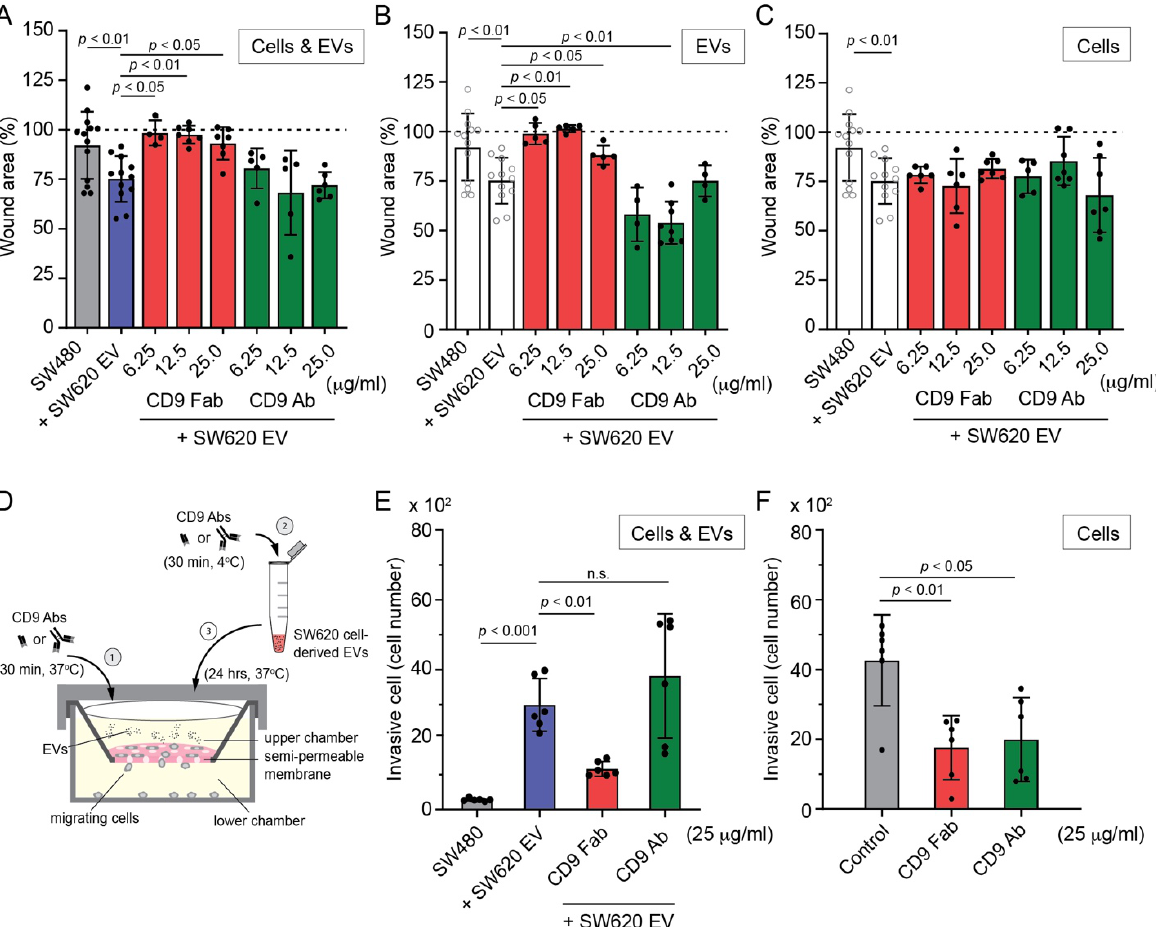
Figure 5. Effects of CD9 Fab and divalent Ab on the migration of SW480 cells exposed to SW620 cell-derived EVs. ( A ) The migration–wound healing assay was performed by introducing a scratch on confluent SW480 cell monolayers cultured on 12-well standard cell culture plates and incubating them for 5 h in the absence (negative control, grey) or presence (positive control, blue) of SW620 cell-derived EVs (1 × 10 9 particles/mL). Alternatively, after introducing a scratch on the cell monolayer, cells and EVs were individually pre-incubated for 30 min with different concentrations of anti-CD9 Fab (red) or divalent Ab (green) as indicated before their 5 h co-incubation in the presence of Abs ( A ). The percentage of remaining wound areas after 5 h was quantified. Baseline (100%, dashed line) refers to wound area at 0 h. ( B , C ) Solely EVs ( B ) or cells ( C ) were pre-incubated for 30 min with Abs prior to co-incubation with cells or EVs for 5 h. Wound area was quantified. Controls (white) are shown for comparison. Means ± S.D. from multiple scratches are shown ( n = 4–13). ( D – F ) The migration–Transwell filter assay was performed using a Transwell chamber as illustrated ( D ), where SW480 ( E ) or SW620 ( F ) cells were added to the upper chamber. Cells and EVs were pre-treated, as described in panel A, using 25 μg/mL CD9 Fab or divalent Ab (( D ), steps 1 and 2) before 24 h of co-incubation (( D ), step 3). In the case of SW620 cells, they were not incubated with EVs ( F ). The amount of migrating cells recovered in the lower chamber was then quantified. Each individual value is shown. p values are indicated. n.s., not significant.